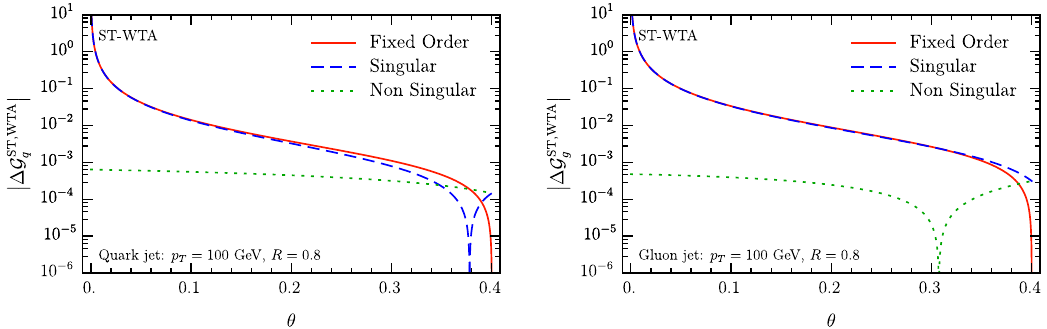
ST ; WTA (red solid), G ( (cid:11) s ). The nonsingular (green O